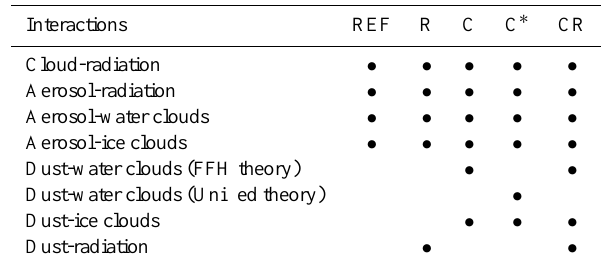
Table 2. Overview of the setup for the nested simulations. The interaction involving aerosol include anthropogenic (if, ic, jf, jc, and s) and sea salt (sa, sb, and sc) modes, whereas dust refers to the dust modes (da, db, and dc)